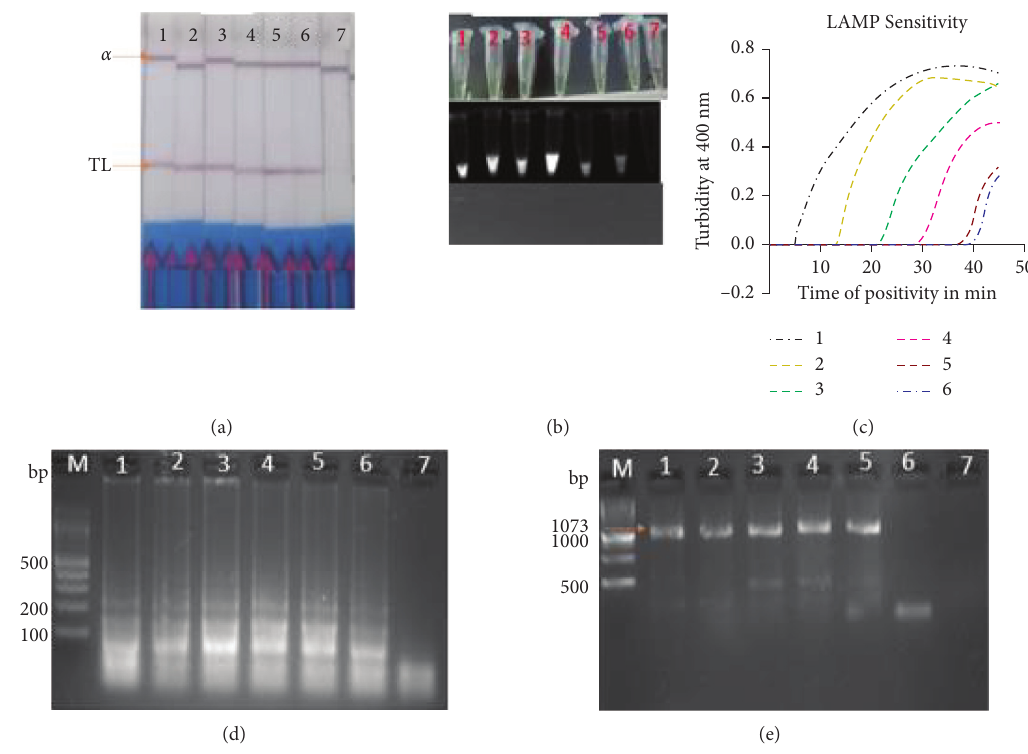
Figure 4: Analytical sensitivity of LAMP and nested PCR products using 10-fold dilutions of E. granulosus DNA at 63 ° C for 40 minutes. (a) LAMP products detected by LFD strips; CL indicates control line and TL indicates test line for positive samples. (b) Visual detection of LAMP products using SYBR Green 1 dye under visible (green) and UV light (bright fluorescence), respectively. (c) Real-time LAMP turbidity monitored by a Loopamp real-time turbidimeter at 400nm. The amplification curve graph was generated by GraphPad Prism software version 8.00. (d) 3% agarose gel electrophoresis of LAMP products. (e) Nested PCR products analysis on 1.5% agarose gel; M: DNA molecular marker; N: no template control; 1–7: 10-fold serial dilution of E. granulosus DNA from 10 − 1 to 10 − 7 (1 ng to